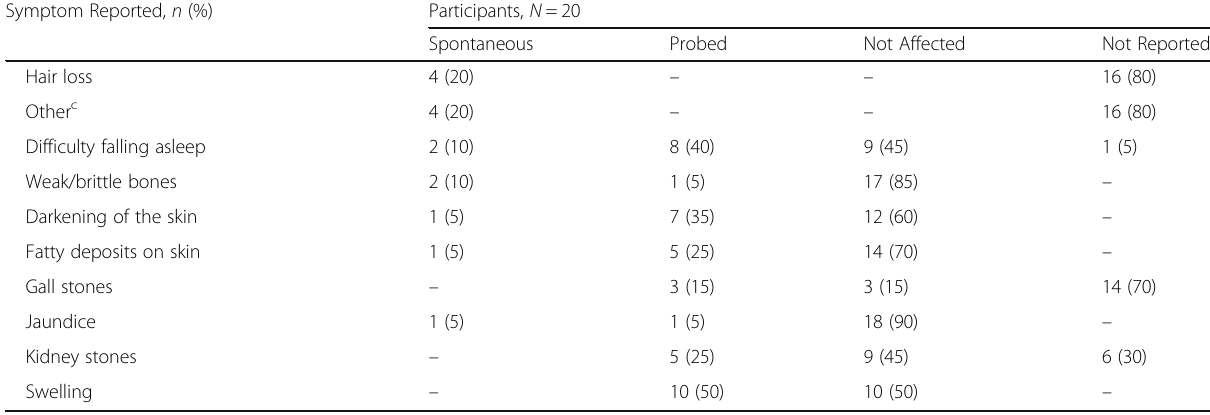
Table 3 Spontaneous vs probed symptom expressions during the CE portion of the interviews (Continued) Symptom Reported, n (%)